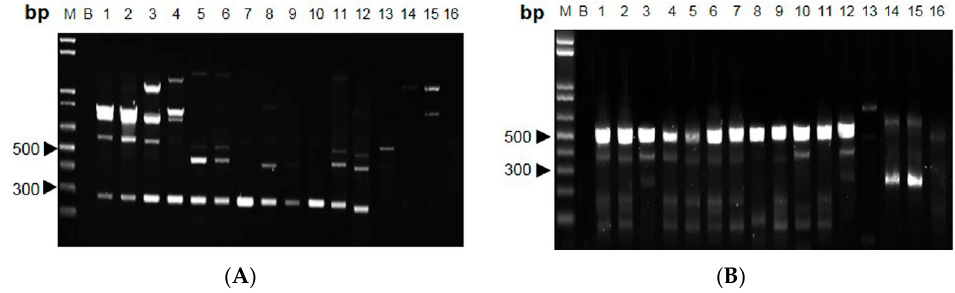
Molecules 2015 , 20 , page–page